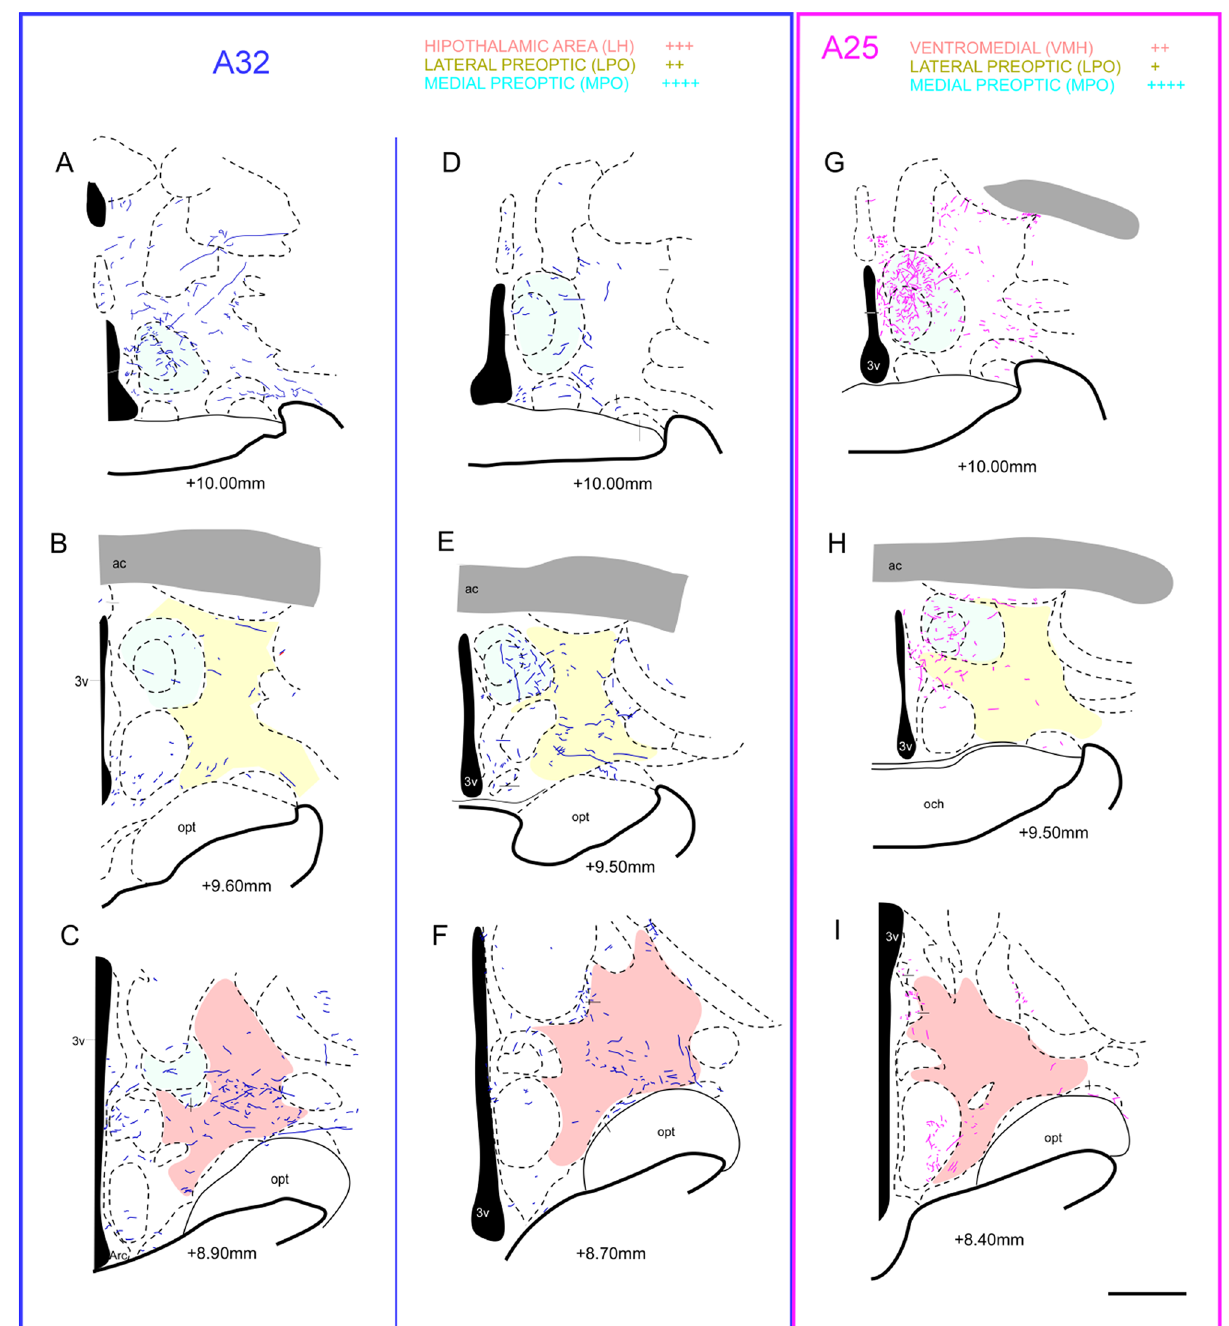
Figure 4. Location of the fibers from the A32 (blue) and A25 (purple) cortex in the hypothalamic complex. ( A – C ) case 1 (A32); ( D – F ) case 2 (A32); ( G – I ) case 3 (A25); Pink: Lateral preoptic area; Yellow: Lateral hypothalamic area; Green: Medial preoptic area; Scale bar: 1000 µm . The figure was drawn in Canvas software version 12.0 76 coming exclusively from A32, as well as those found in the paralaminar (PaL). The A25 cortex did not project to these nuclei. Finally, the APir area, did not receive axons from any of the cortices A32 or A25. In general, the A25 cortex abundantly projects to the amygdaline nuclei than the A32. The results also support the data from classical research with anterograde tracers 42–44 , which is evidenced as an important source for the reception of prefrontal projections in the amygdala to the deep nuclei. In a retrograde tracing study with Old World monkeys 45 , it was observed that there is connectivity between intermediate and magnocellular regions of the AB and B nuclei with the mPFC. As indicated earlier, our data pointed out anterograde marking from A32 and A25 in the mPFC to this region and the group of B nuclei (Fig. 9). This observation suggests the presence of reciprocal connections between these cortical and subcortical areas.